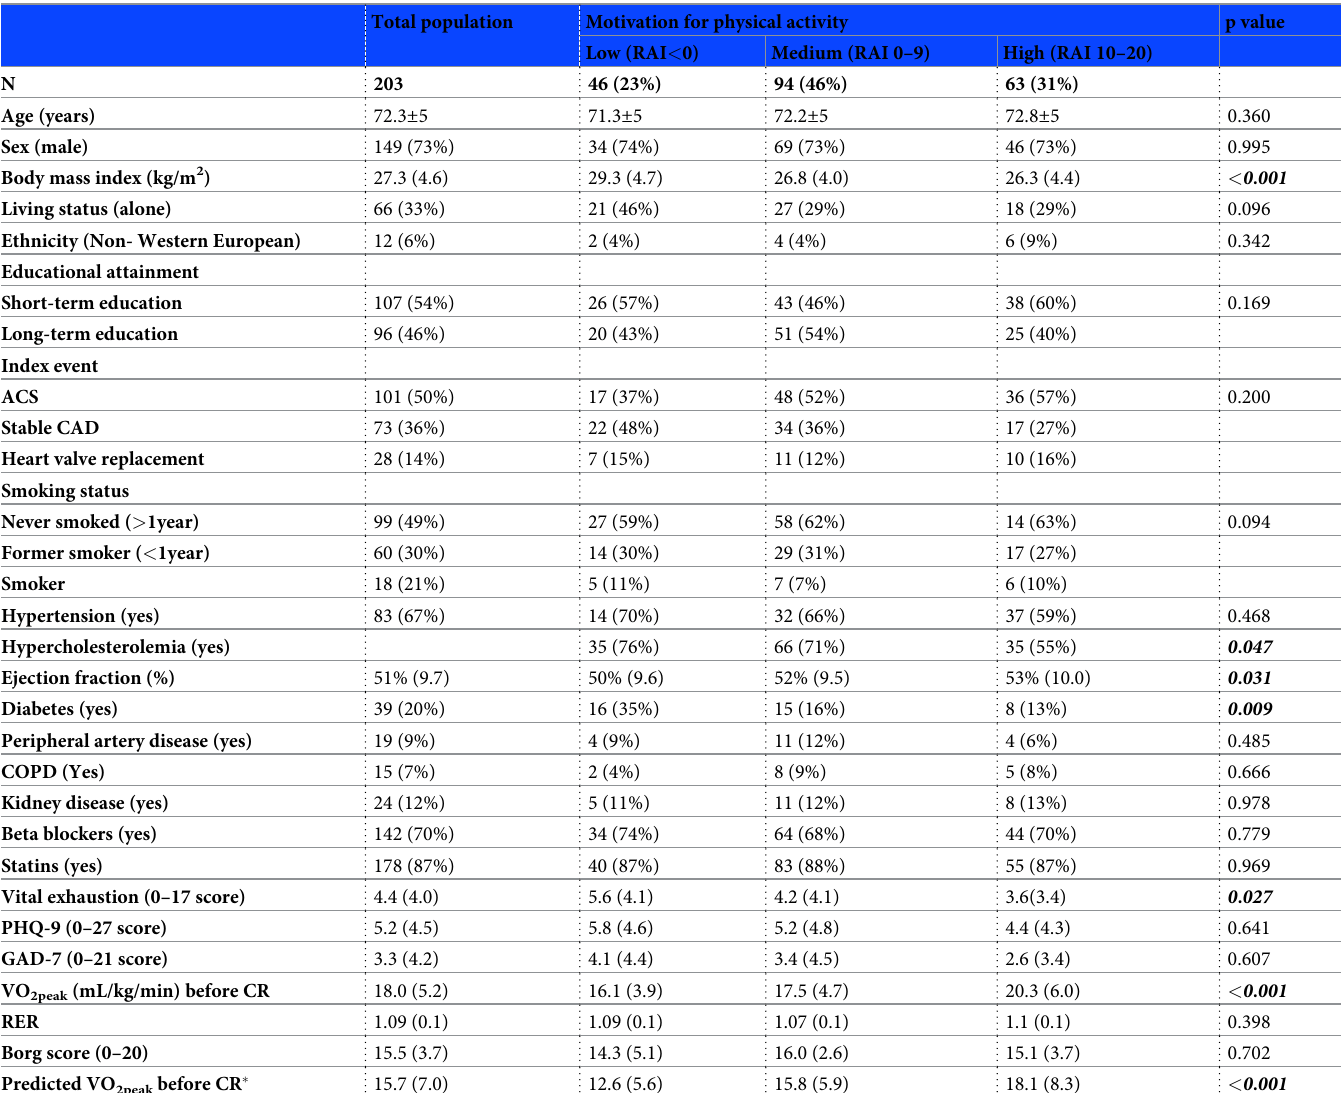
Table 1. Patient characteristics by level of motivation at the